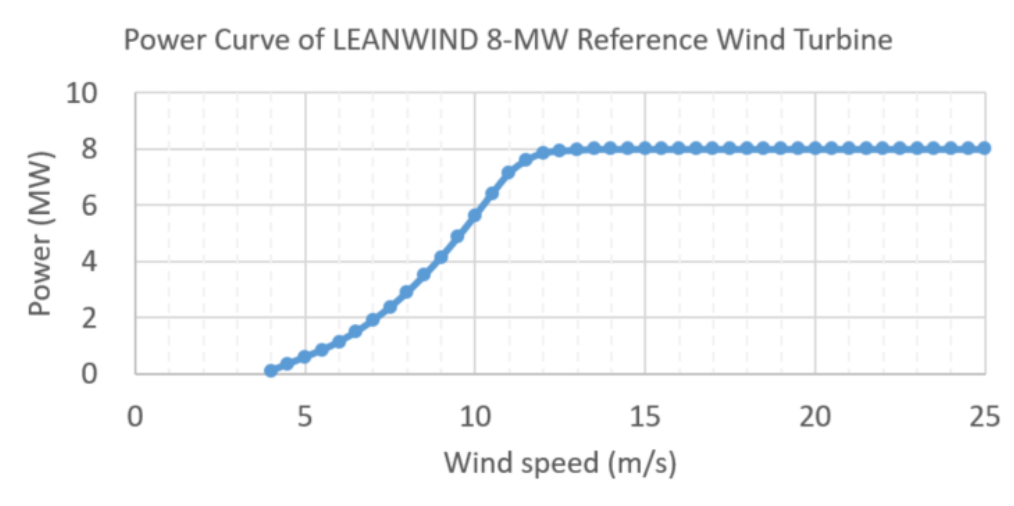
Figure 11. The power curve of LEANWIND 8MW reference wind turbine.